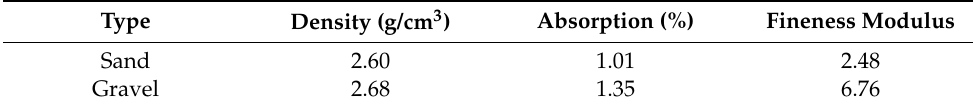
Table 5. Physical properties of the